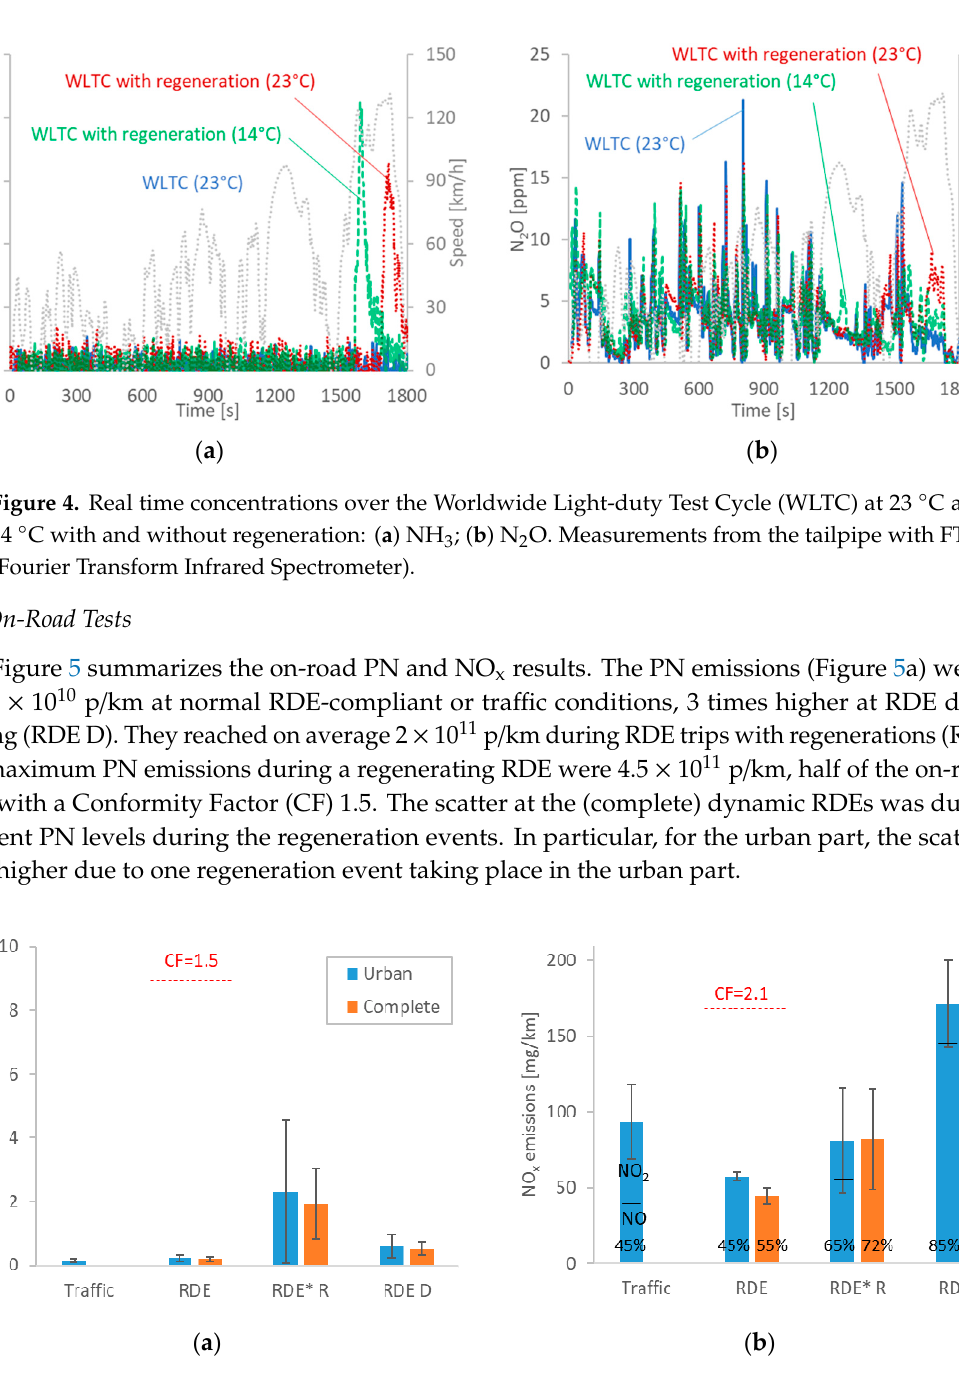
Figure 5. Emissions during on-road tests for the urban part or the complete trip: ( a ) Particle Number (PN) > 23 nm; ( b ) NO x as sum of NO and NO 2 . Percentage gives the ratio NO / NO x . “RDE” refers to RDE-1 and RDE-2 (compliant routes) without any regeneration events. “D” stands for dynamic driving. “RDE* R” includes RDE-1, Motor-City and Motorway routes, all with regeneration events. “Traffic” is the urban route with many stop and go. Error bars show min-max values of two or three routes. The red dotted line gives the Real-Driving Emissions (RDE) limit with the Conformity Factor (CF). The RDE NO x emissions (Figure 5b) were below the applicable NTE limit for the specific vehicle (with CF = 2.1), even the future Euro 6d limit with CF = 1.43. They were on average below 100 mg /